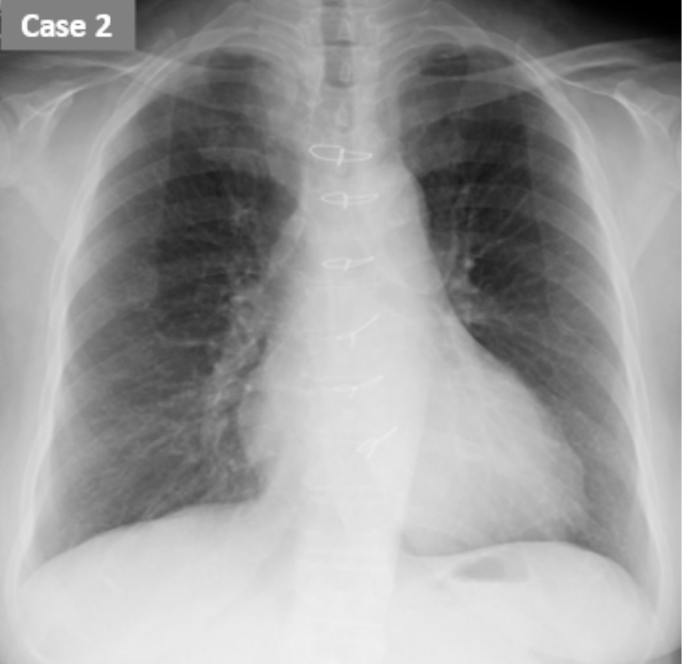
Figure 4. The chest X-ray just before hemodialysis in case 2.